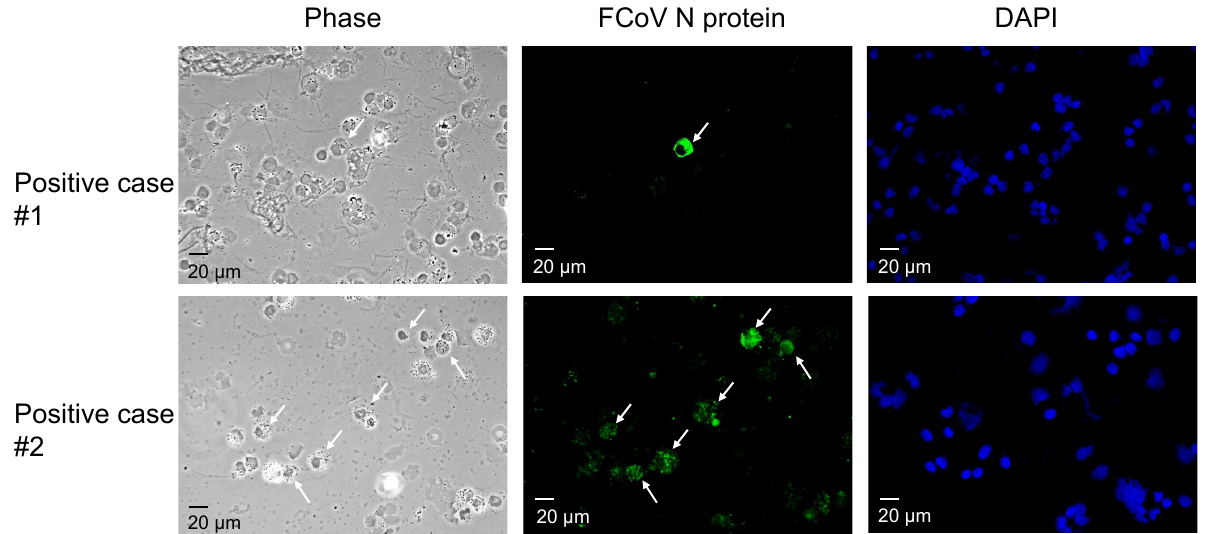
Figure 1. Fluorescence images of the specific cytoplasmic FCoV N protein signal in cats’ effusion samples. In the field of phase contrast, macrophages were identified. The arrows indicate the cytoplasmic antigen signals, and the nucleus was stained with DAPI.